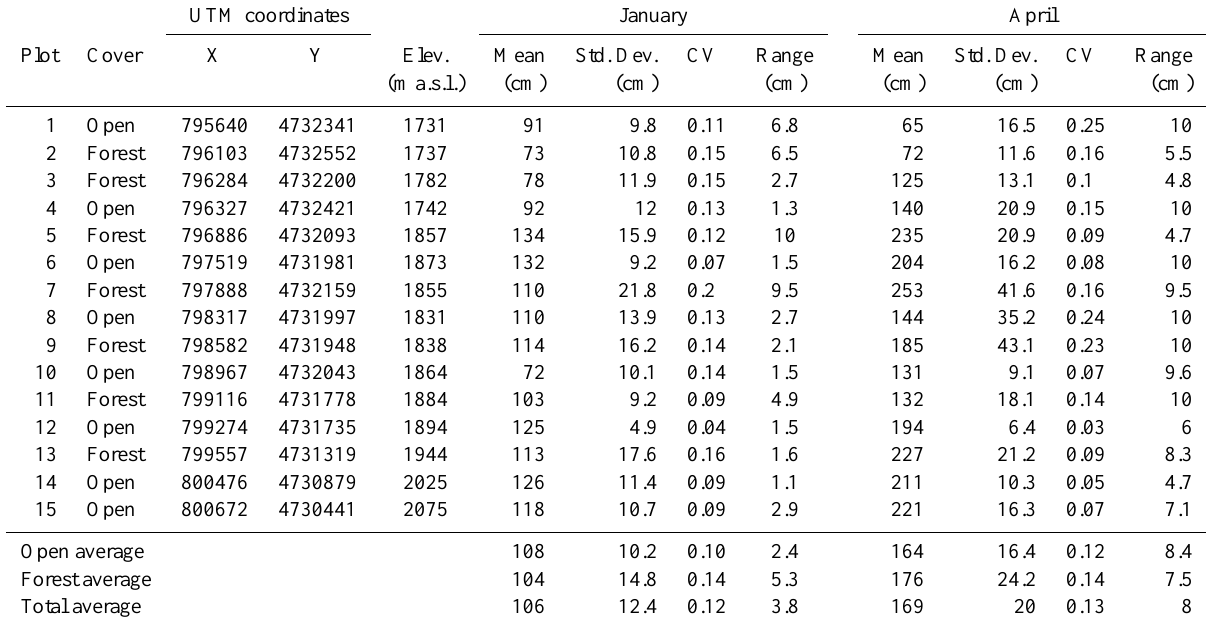
Table 1. Summary data for the study plots. Location and main statistics: mean (cm), standard deviation (cm), coefficient of variation (CV) and semivariogram range